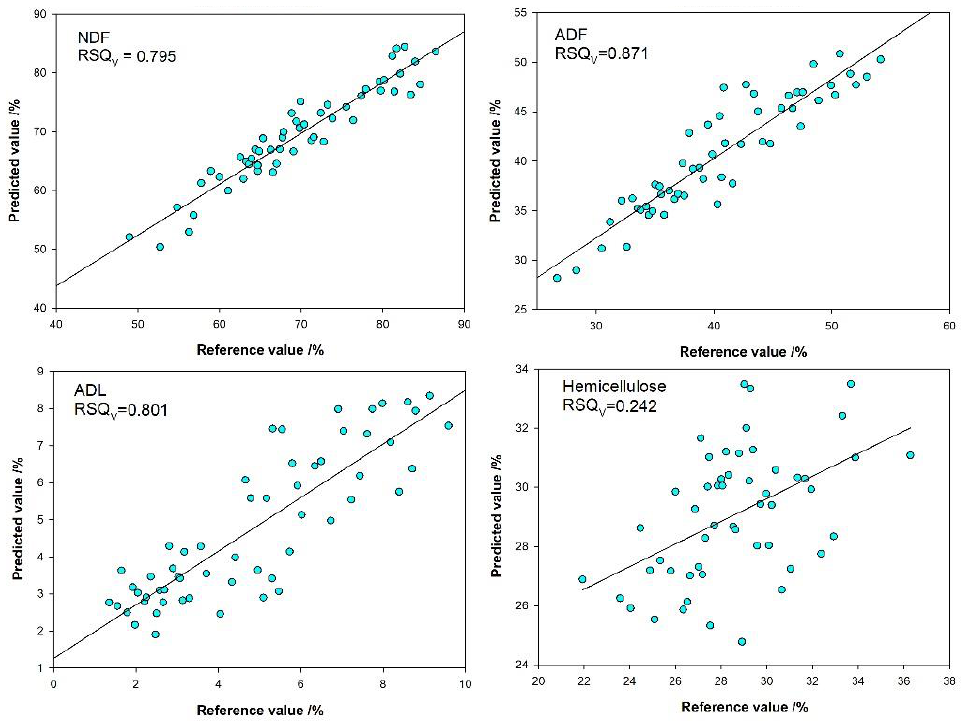
Figure 2. Scatter plot of laboratory reference values versus NIRS predicted values for calibration sets of nutrition quality constituents of all straw samples.